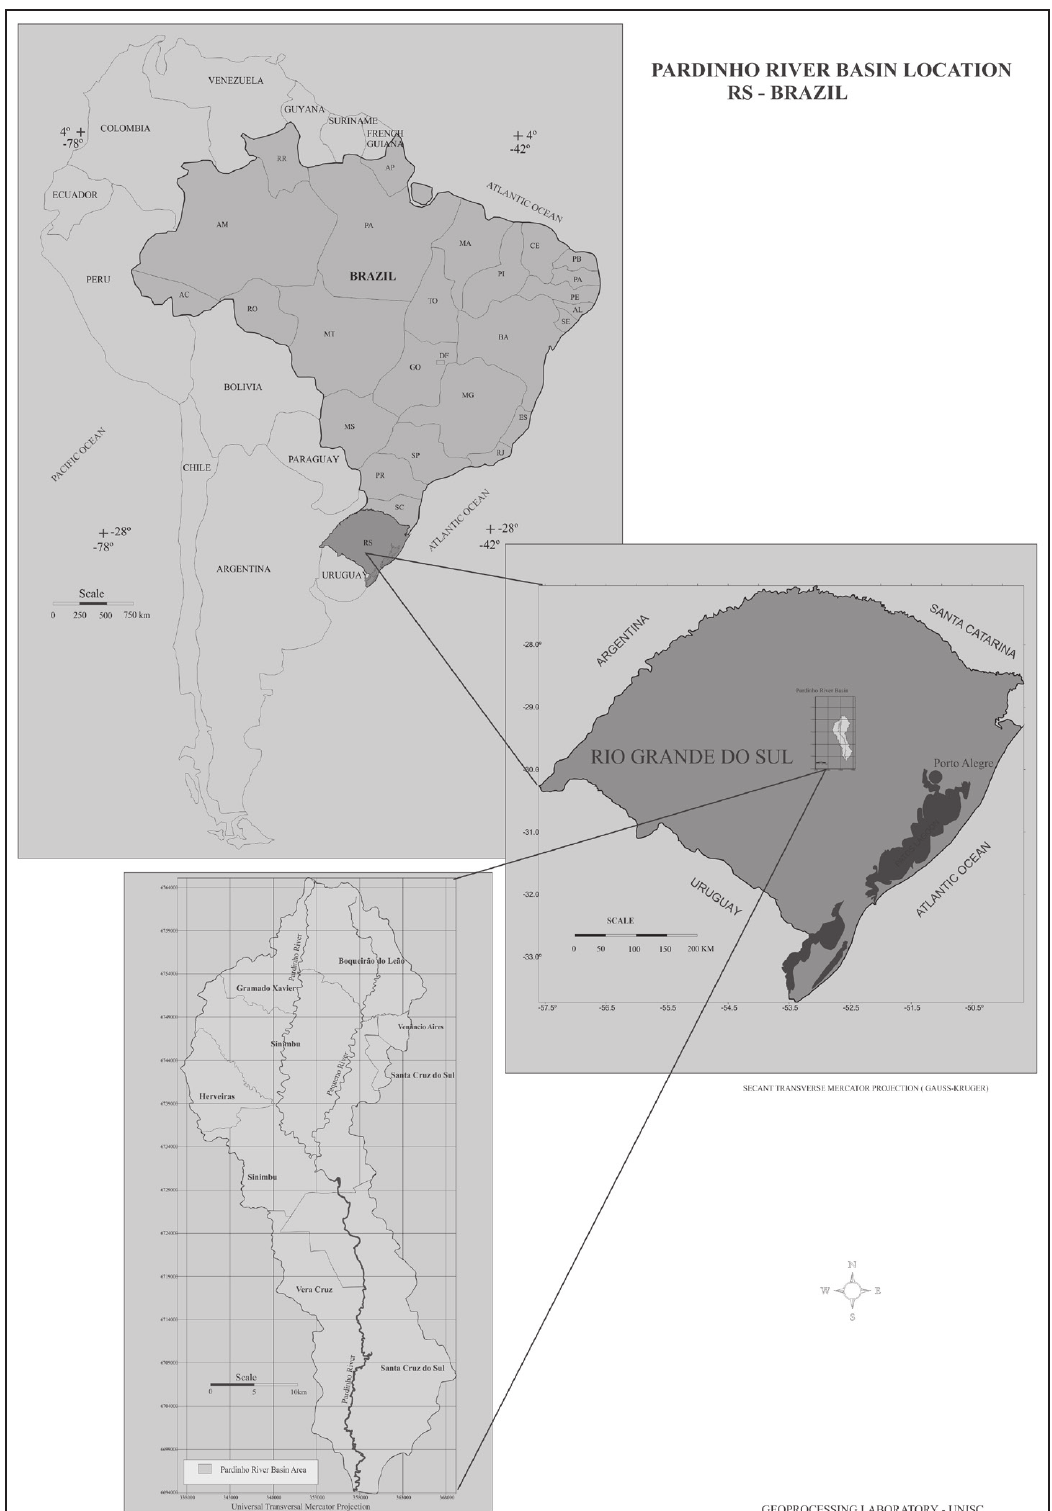
Figure 1 - Location of the Pardinho River Basin, RS,